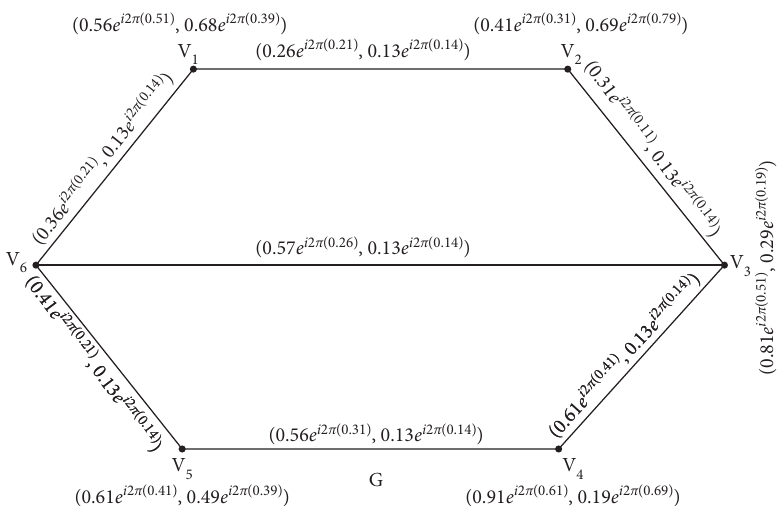
Figure 10: Complex QROF planar graph without weak edges.